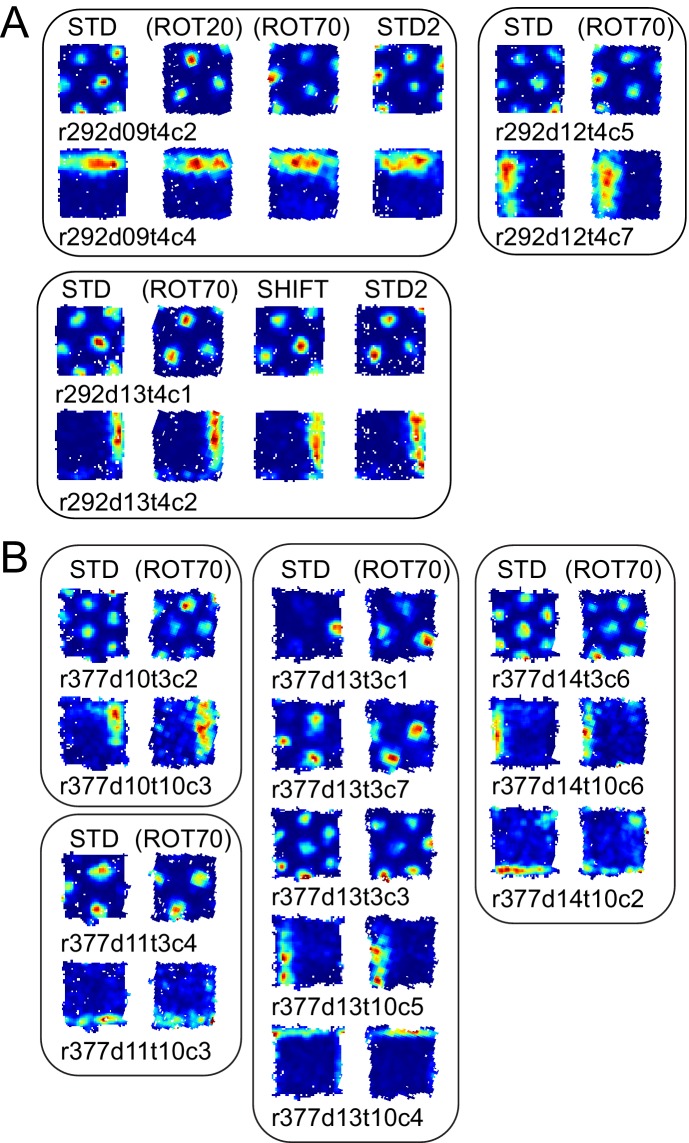
More examples of grid and boundary cells recorded simultaneously from rats 292 (A) and 377 (B).Each simultaneously recorded set is in a separate bounding box. The rate maps for sessions labeled in parentheses were rotated to aid visual comparison of the changing firing patterns of grid cells vs. the repeating patterns of boundary cells. Rate maps for all sessions in which these cells were recorded are given in Figure 6, Figure 6—figure supplement 2 (rat 292) and Figure 7—figure supplement 1 (rat 377).